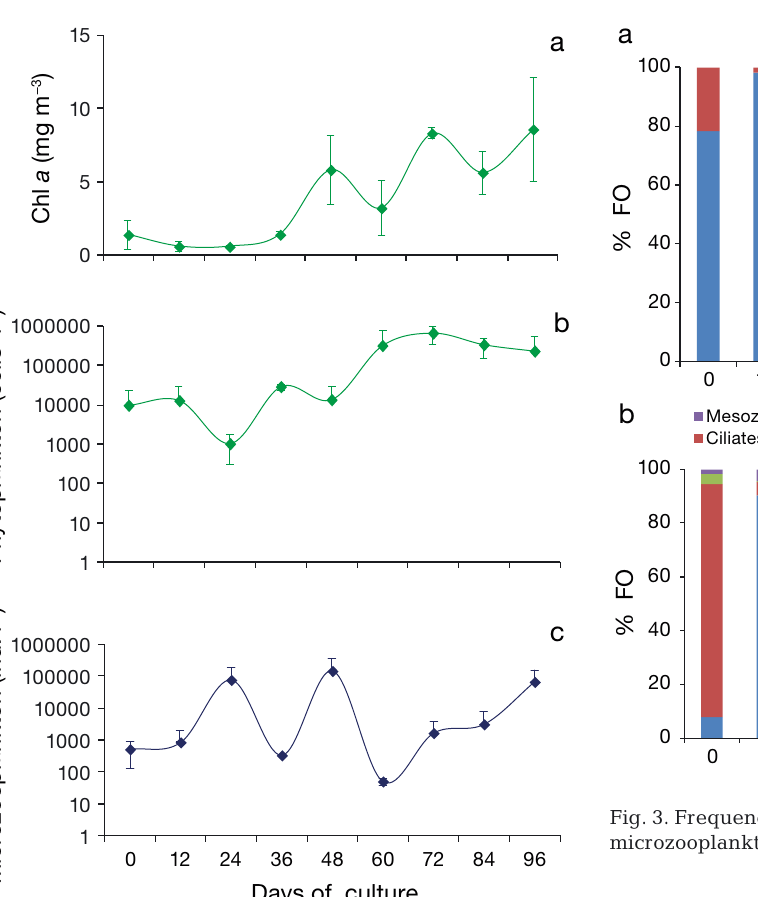
Fig. 2. Temporal variation in (a) concentration of chl a and abundances of (b) phytoplankton and (c) microzooplankton during the culture of Litopenaeus vannamei. Data are mean ± SD (n = 6)